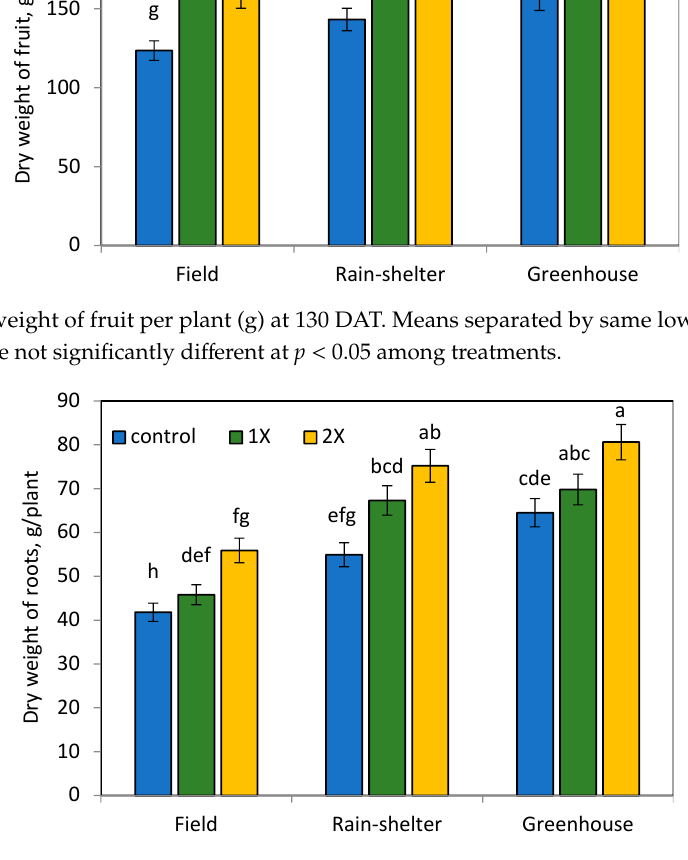
Figure 2. Dry weight of root weight per plant (g) at 130 DAT. Means separated by same lower case letter in each column are not significantly different at p < 0.05 among treatments. LSD = least significant difference.